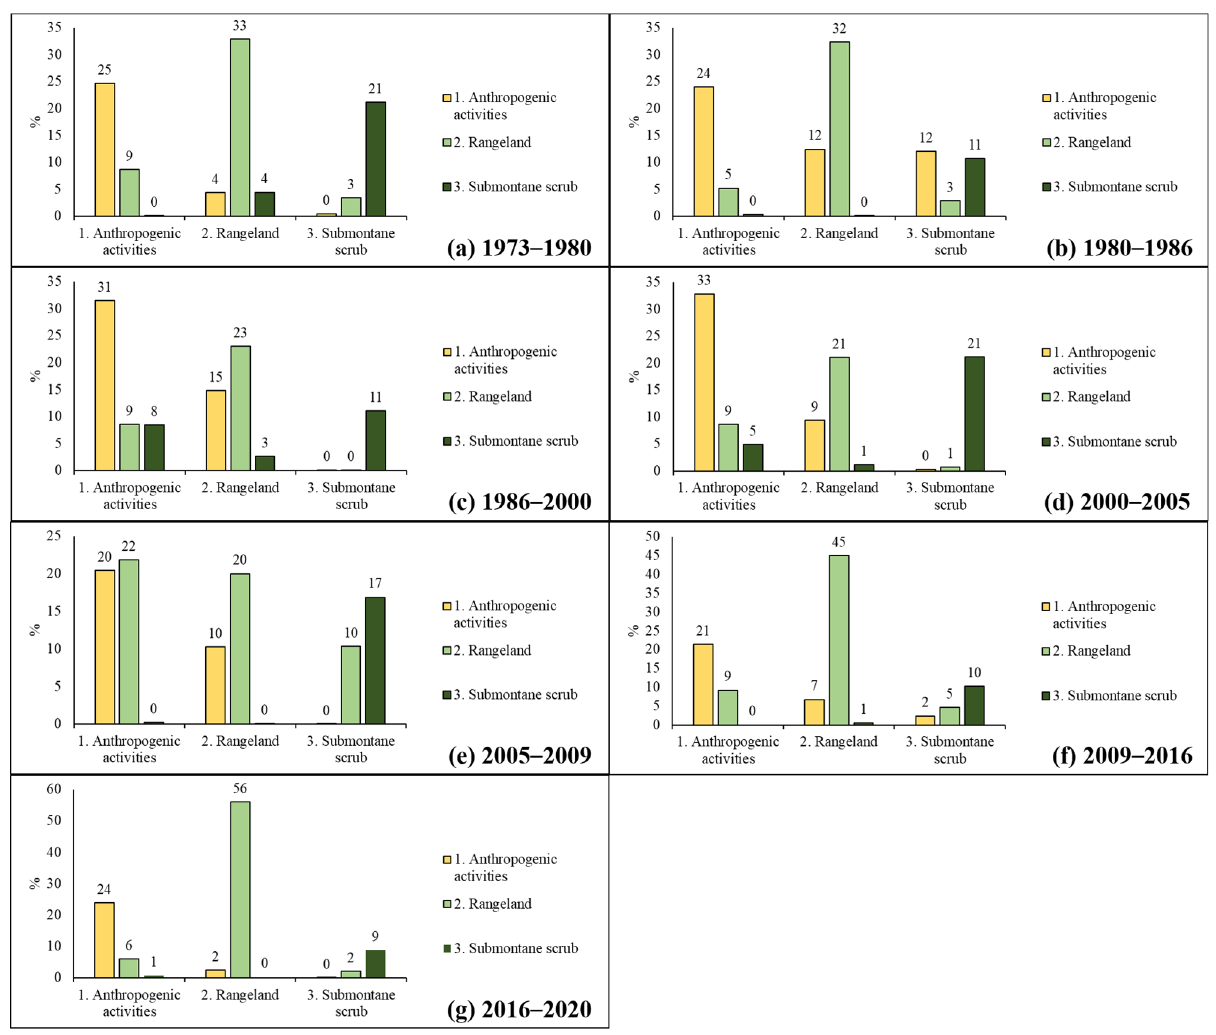
Figure 4. Percentage of changes in land cover in the scenes of ( a ) 1973–1980, ( b ) 1980–1986, ( c ) 1986–2000, ( d ) 2000–2005, ( e ) 2005–2009, ( f ) 2009–2016, and ( g ) 2016–2020, San Rafael, Tula, Tamaulipas, Mexico.